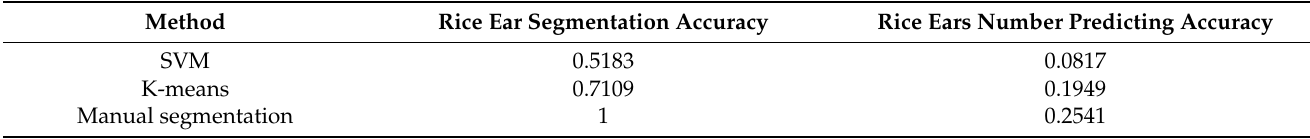
Figure 7. Segmentation result of the rice images: ( a ) SVM segmentation method; ( b ) K-means segmentation method; ( c ) manual segmentation in Photoshop. Table 3. Rice ear segmentation accuracy and coefficient of determination (R2) for regression between mature rice density and rice ear segmentation area